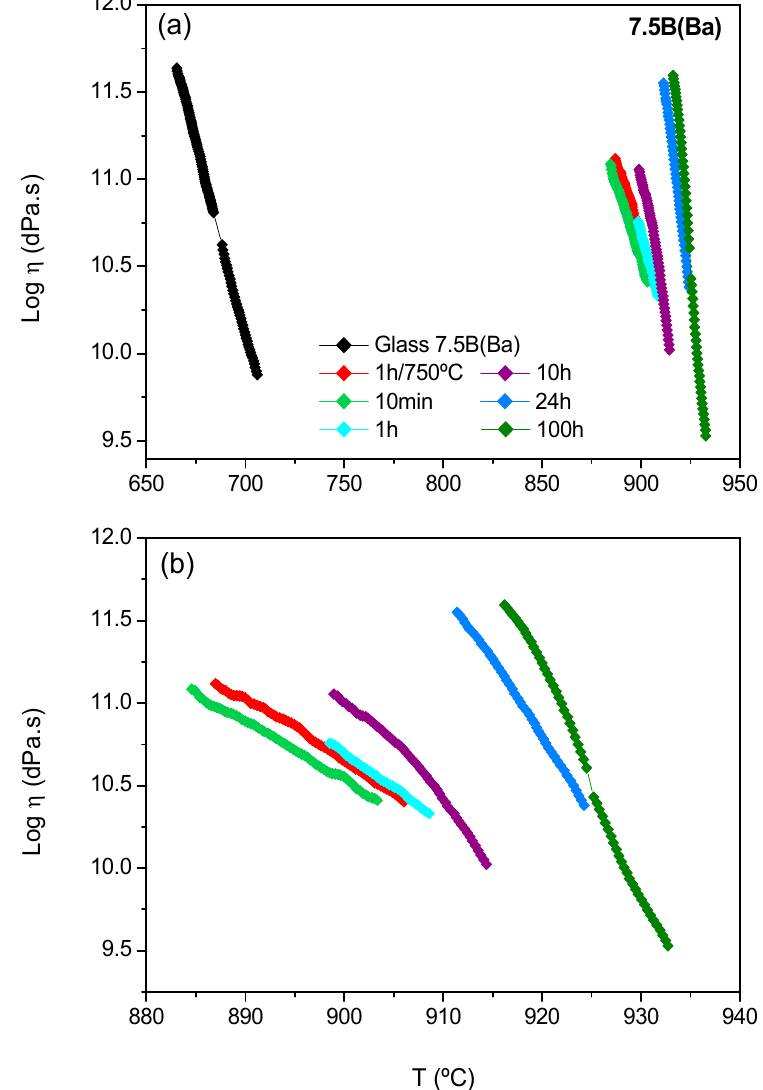
Figure 8. ( a ) Viscosity of the 7.5B(Ba) glass-ceramics as a function of the crystallization degree. ( b ) Viscosity of the glass-ceramics (amplification). Treatment temperature: 800 °C.